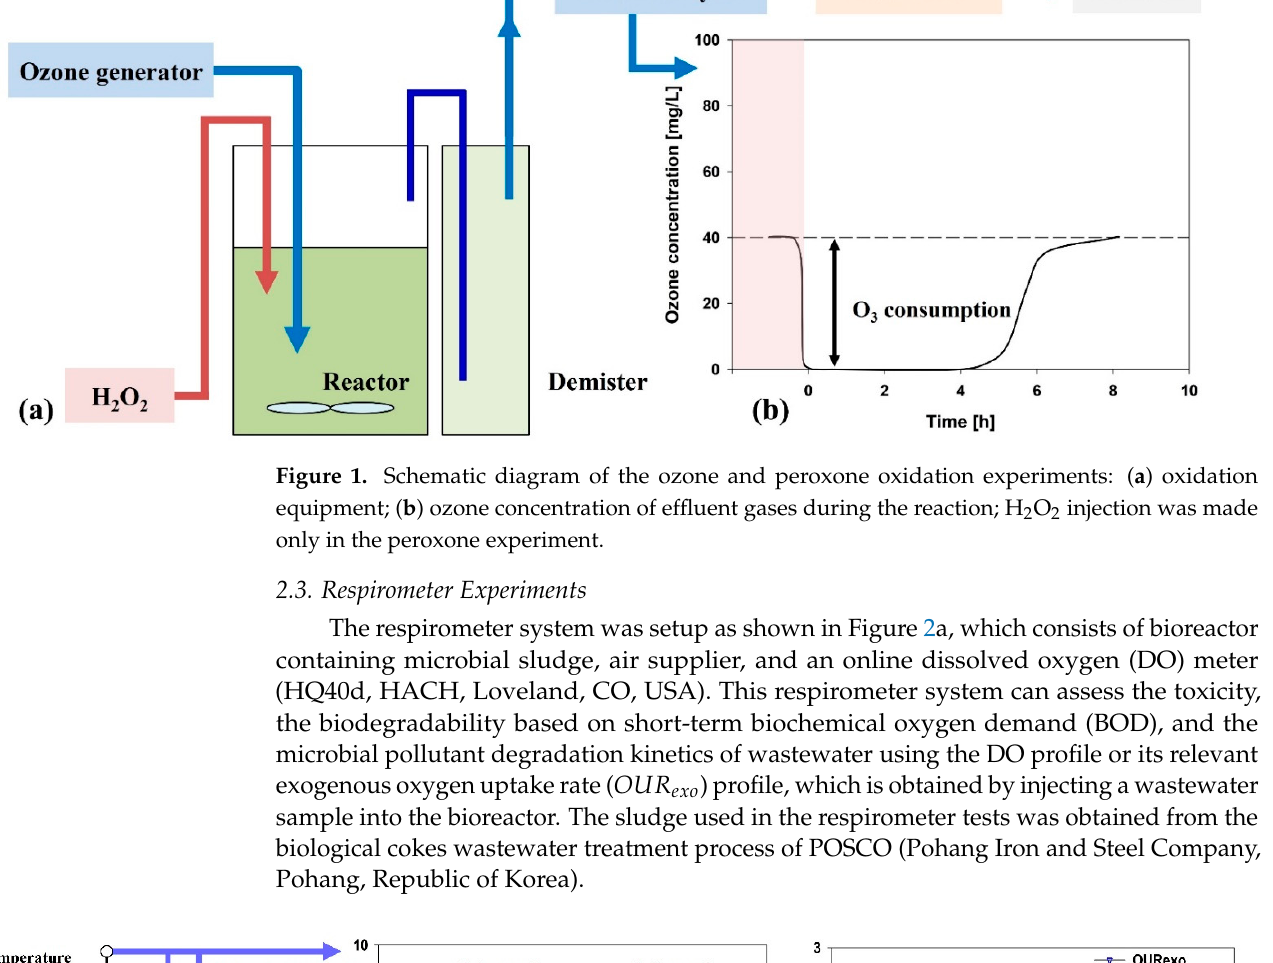
Figure 1. Schematic diagram of the ozone and peroxone oxidation experiments: ( a ) oxidation equip- ment; ( b ) ozone concentration of effluent gases during the reaction; H 2 O 2 injection was made only in the peroxone experiment.